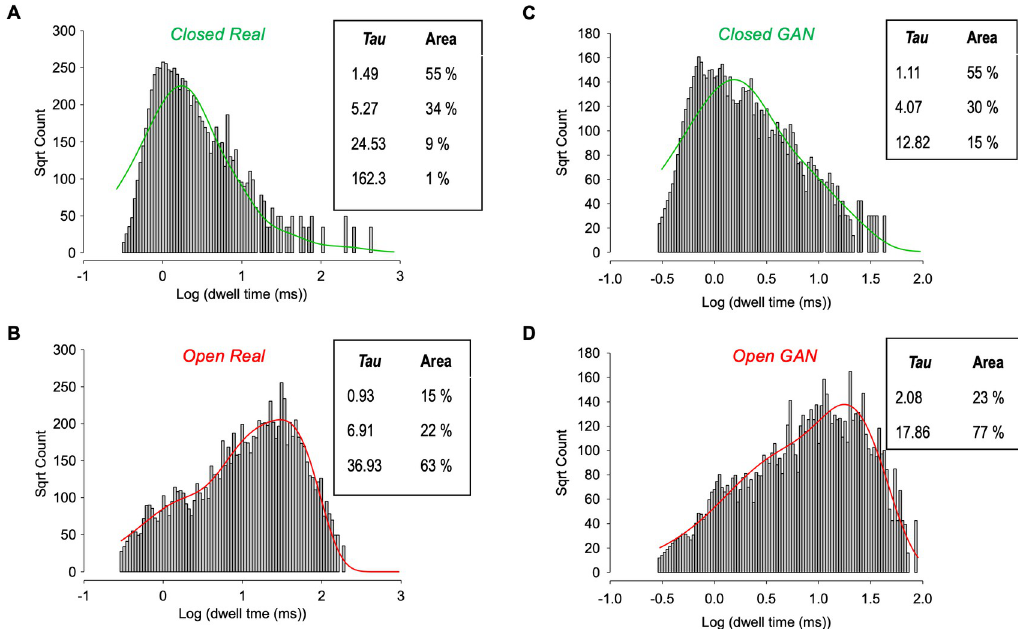
Fig 4. Comparative kinetic analyses of real and DeepGANnel simulated data. (A and B) Kinetic analysis from the real (input) single molecule data with closed times (A) fit with 4 exponentials and open times (B) fit with 3 exponentials. The respective time constants and weights are displayed in the inset tables. (C and D) Kinetic analysis from the GAN simulated (output) single molecule data with closed times (C) fit with 3 exponentials and open times (D) fit with 2 exponentials. The respective time constants and weights are again displayed in the inset